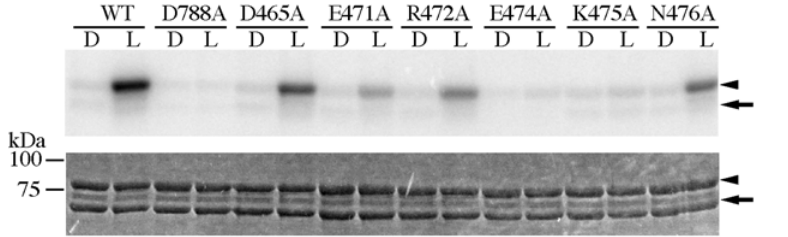
Fig 3. Kinase activity of At phot1 LOV2-STK WT and its amino acid substitutes on P1Nt in the dark (D) or under BL irradiation (L). The upper and lower panels indicate autoradiogram and CBB staining of SDS-PAGE gels, respectively. The arrows and the arrow-heads indicate the position of LOV2-STK and P1Nt, respectively.